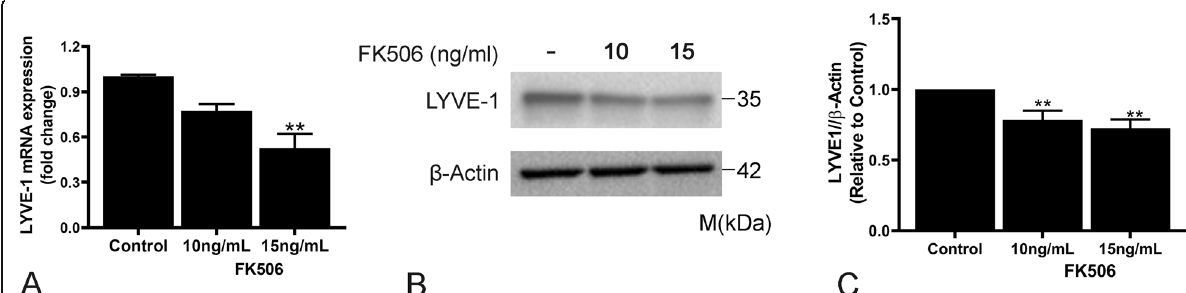
experiments (** < 0.01 one-way ANOVA). Whole lysates of lung lymphatic endothelial cells were subjected to Western blot analysis with antibodies against LYVE-1 and β -actin ( b ). Ratio of LYVE-1 ( c ) to β -actin density was expressed as fold-change relative to control. Data represent